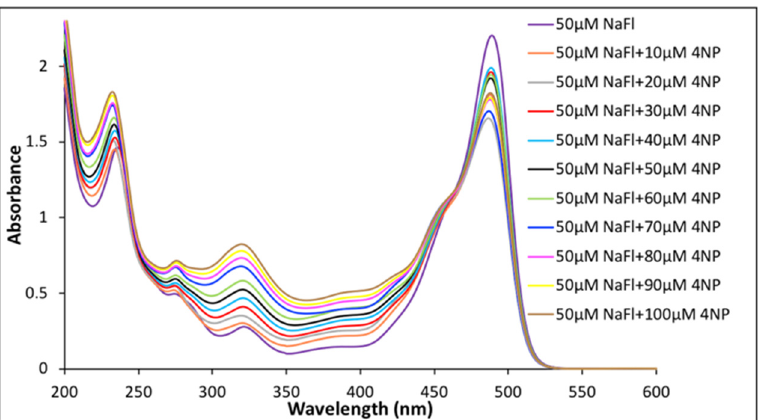
Figure 3. Absorbance spectrum of 50 µM of NaFl in presence of different concentrations of 4NP in water.